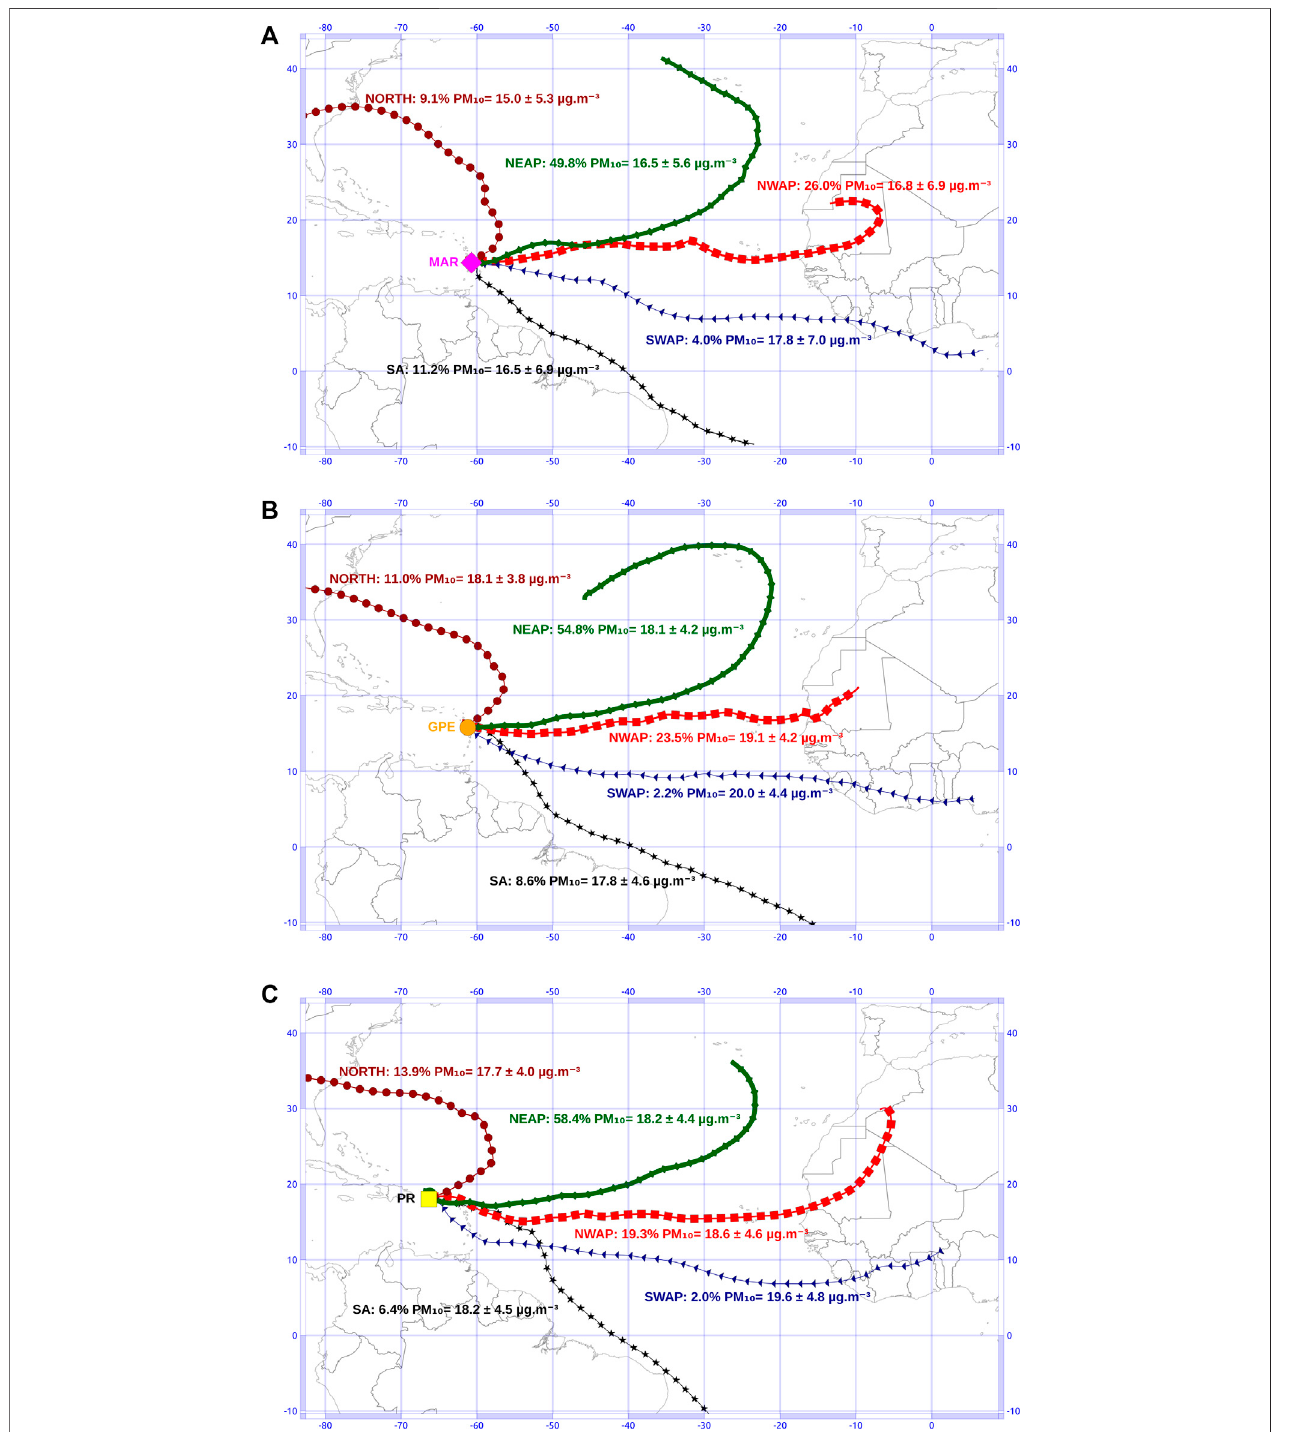
FIGURE 7 | Cluster of daily back trajectories (in percentage) with their descriptive statistics (Mean ( (cid:2) M ) , Standard deviation ( σ )) for (A) Martinique (MAR), (B) Guadeloupe(GPE)and (C) Puerto-Rico(PR)from2006to2016associatedwithnon-dustydays( PM 10 < 28 μ g/m 3 )bypathaccordingtoEuphrasie-Clotildeetal.(2020) classi fi cation: NWAP, SWAP, NEAP, SA, North.